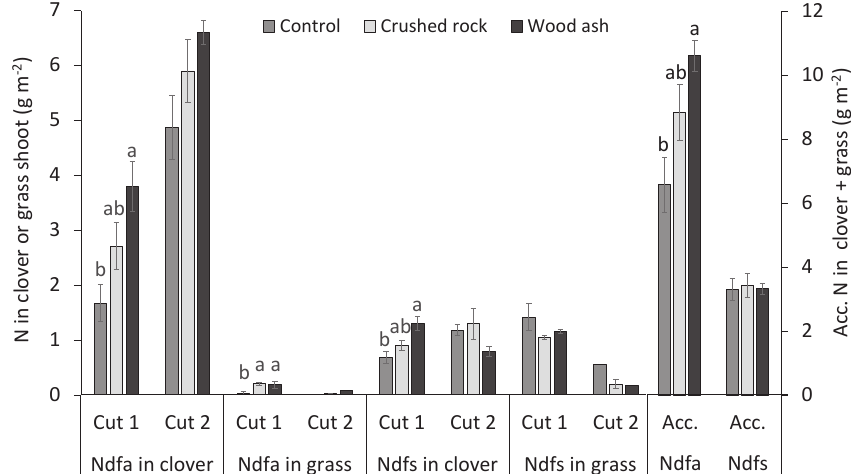
Fig. 3. Amounts of N derived from air (Ndfa) and soil (Ndfs) in red clover and perennial ryegrass shoots at cuts 1 and 2 (primary y axis) and total amount accumulated in clover + grass across the two cuts (secondary y axis). Data are given as Least-Squares Means, error bars indicate SEM and letters (a, b) indicate significant differences between treatment for each species at each cut, and between treatments for the accumulated amounts ( p ≤0.05;